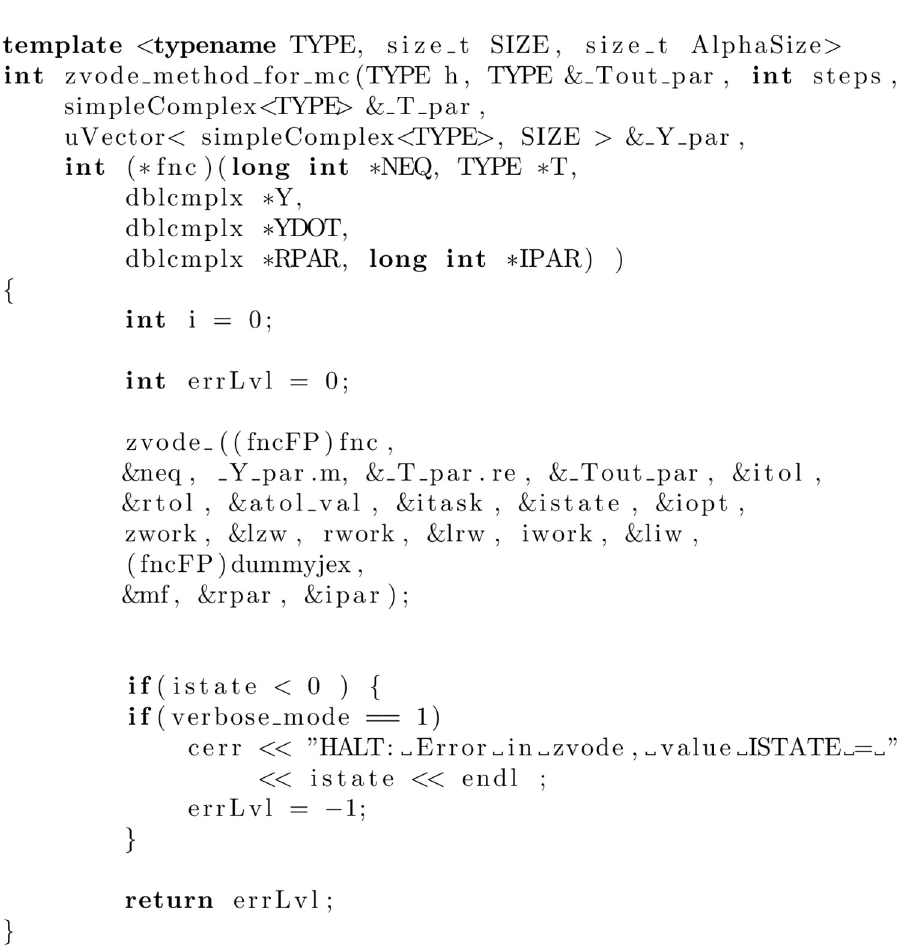
Fig 3. A function solving IVP (for a time-independent Hamiltonian) with the use of the zvode_ method from the ZVODE package. The underscore placed in the name of the method is a requirement imposed by the Fortran